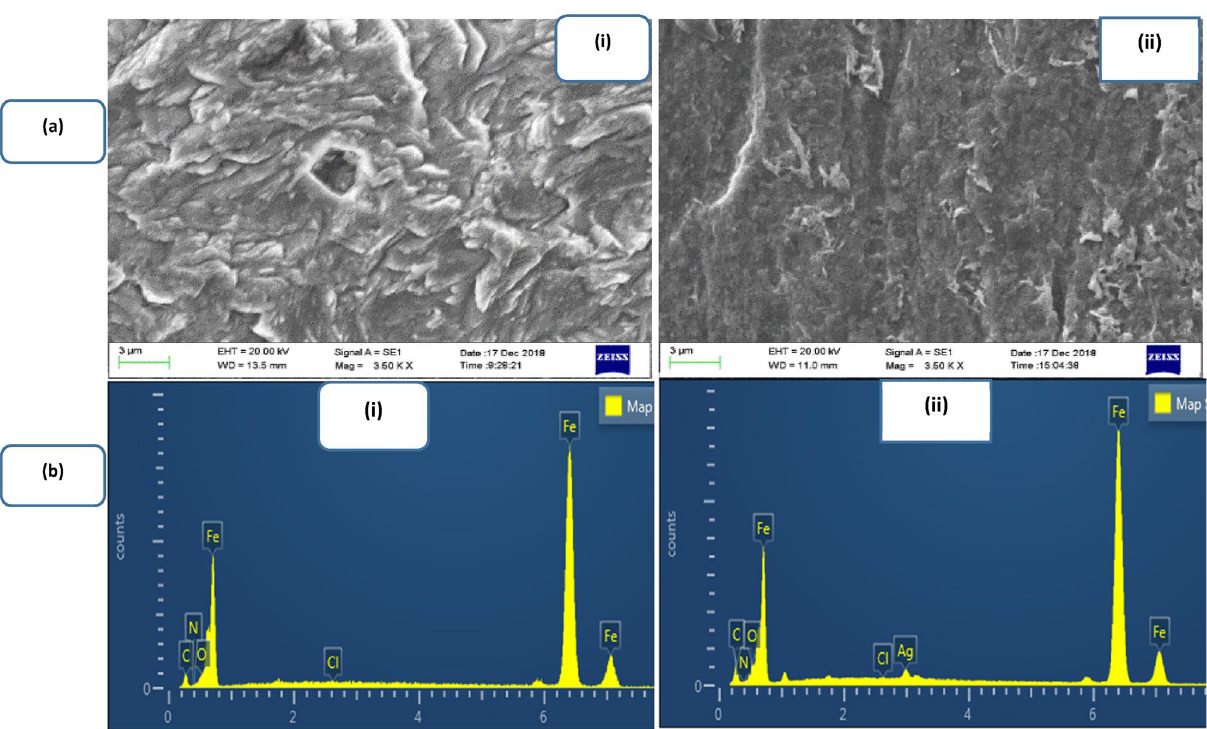
Fig. 10 a SEM micrographs and b EDS spectra of X80 steel surface retrieved from (i) 1 M HCl solution and (ii) 1 M HCl solution inhibited with 20%